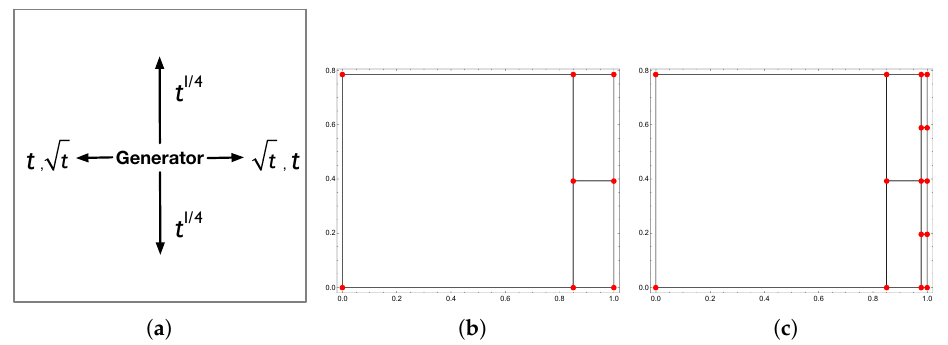
Figure 7. Cylindrical shell: Layer structure. Examples of minimal meshes for a case with a generator at x = 1 with t = 1/100. ( a ) Layer structure for the axial directions, there also exists a possible smooth component spanning the entire domain. ( b ) Mesh adapted for